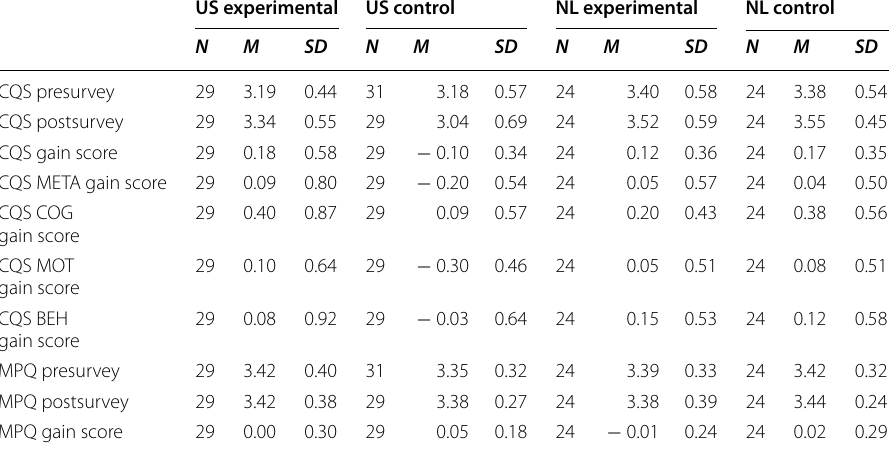
CQS: Cultural Intelligence, CQS META: Metacognitive, CQS COG: Cognitive, CQS MOT: Motivational, CQS BEH: Behavioural, MPQ: Multicultural Personality